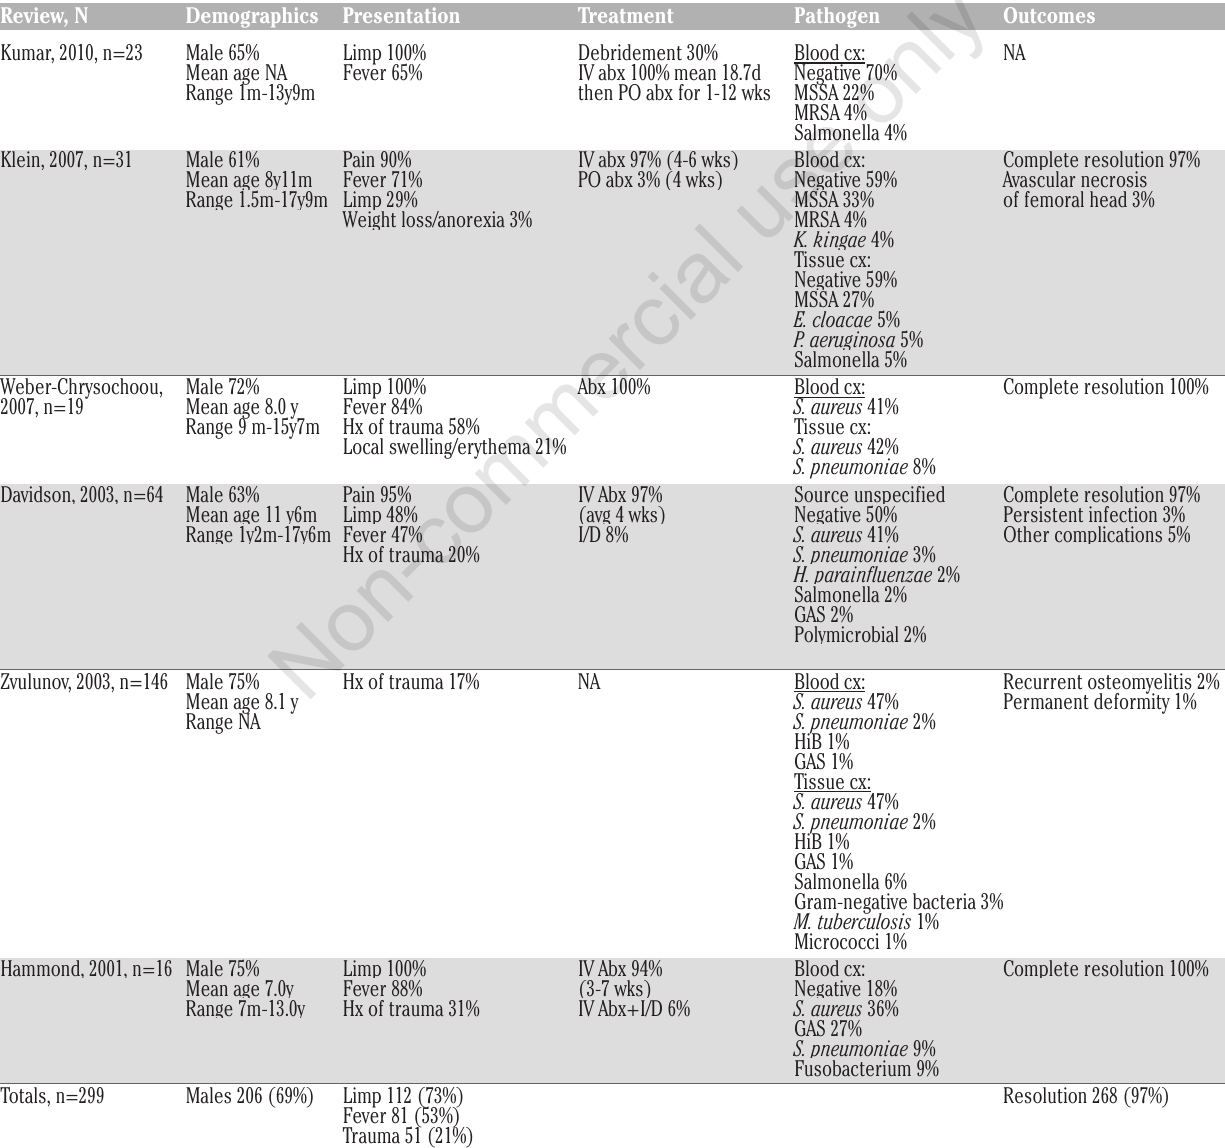
Table 1. Summary of published pediatric pelvic osteomyelitis cases series. Review,